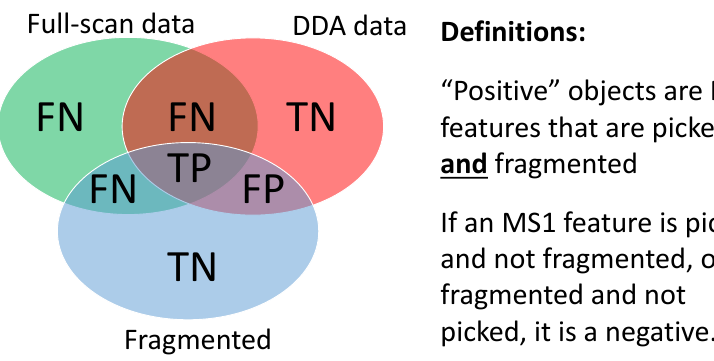
Figure 4. Definitions of True Positives (TP), False Positives (FP), True Negatives (TN) and False Negatives (FN) for performance evaluation of Top- N DDA fragmentation strategy. The blue circle in the Venn diagram refers to all MS1 features that are fragmented above the minimum MS1 intensity threshold, the green circle refers to all MS1 features found by XCMS’ CentWave from the full-scan file, while the red circle refers to all MS1 features found by CentWave from the fragmentation file.